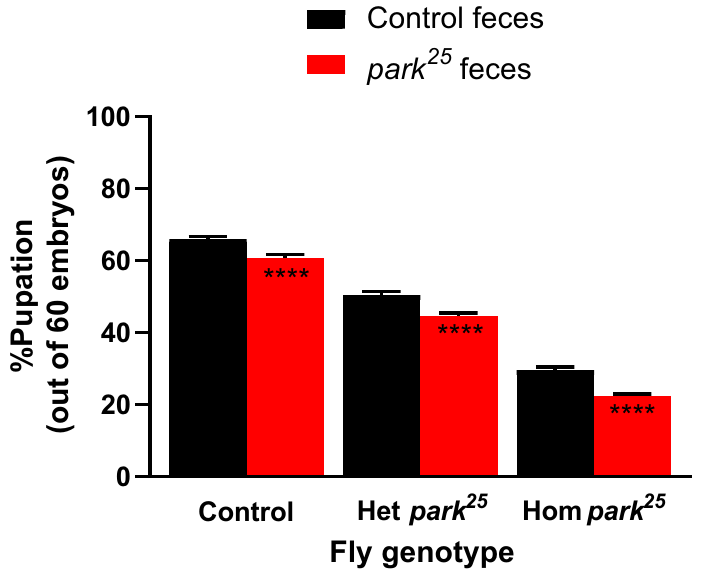
Figure 1. Feces from park 25 flies reduces total pupation rate. Total pupation rates were calculated in control, heterozygous (Het) park 25 and homozygous (Hom) park 25 flies from the 60 embryos that were placed on food that had control or park 25 feces present. Data are presented as mean and SEM. Asterisks represent the results of a post-hoc Sidak’s multiple comparisons test comparing the two feces groups within each fly genotype (**** = P < 0.0001). Results are from 45 separate vials in each